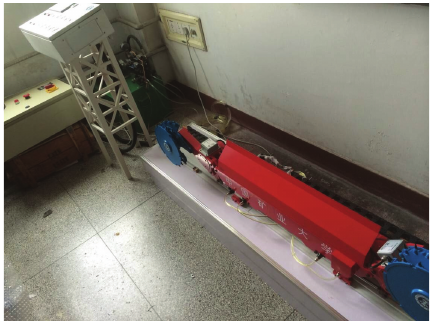
Figure1:Hydraulicallydrivenshearerdrumliftingdevelopedbythe China University of Mining and